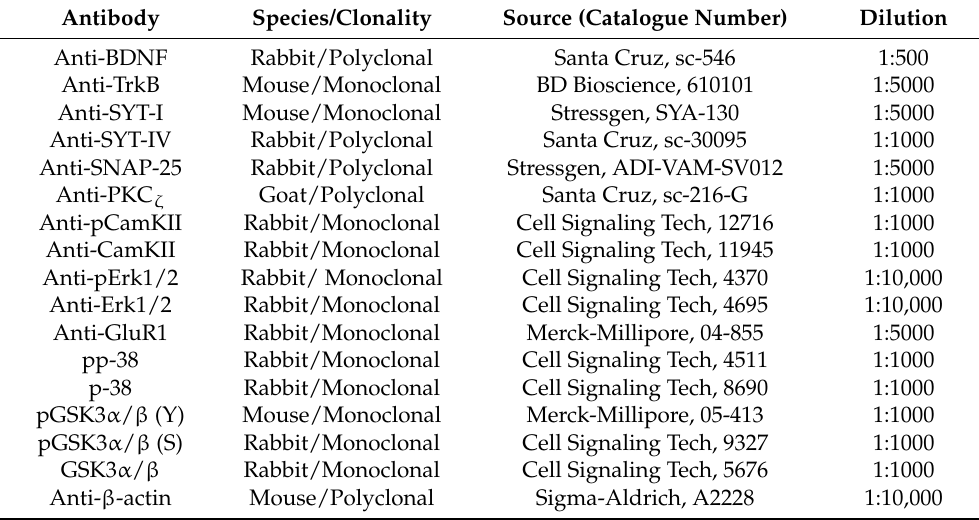
Table 1. Information of primary antibodies used in this present